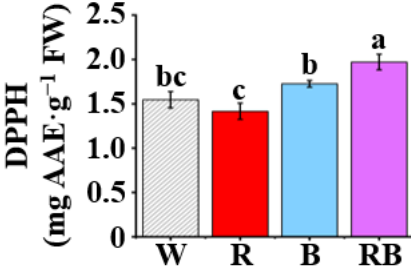
Figure 6. Effect of light quality on 2-diphenyl-1-picrylhydrazyl (DPPH) radical scavenging capacity in leaves of C. triste plantlets after four weeks of culture: The light qualities used were W, white LED; R, red LED; B, blue LED; and RB, combined red and blue LEDs in a 1:1 ratio. The results were expressed as means ± standard errors ( n = 3). Different letters indicate significant differences ( p < 0.05) by the Tukey’s multiple range test.